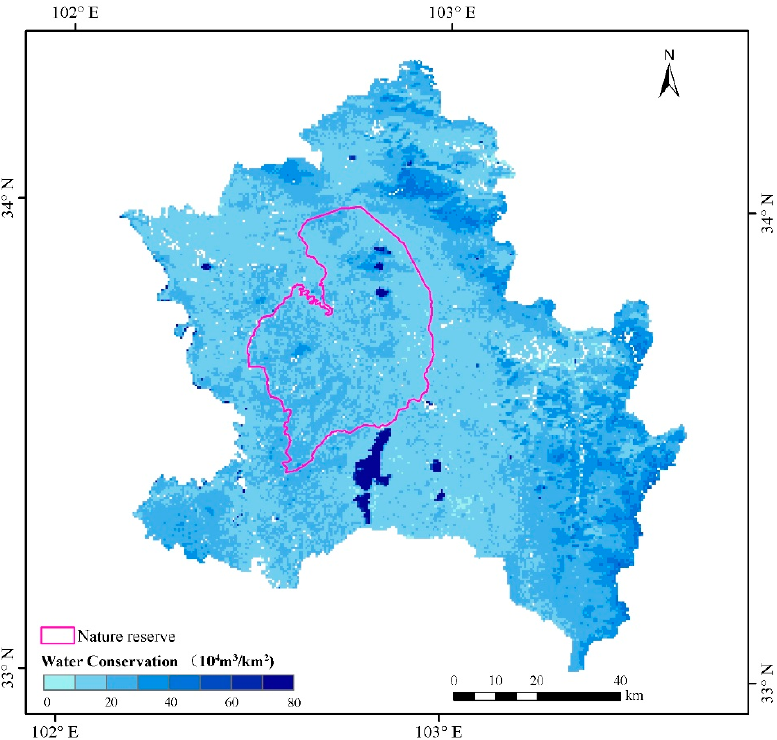
Figure 8. The mean value of water conservation in Zoige county (2016–2020).